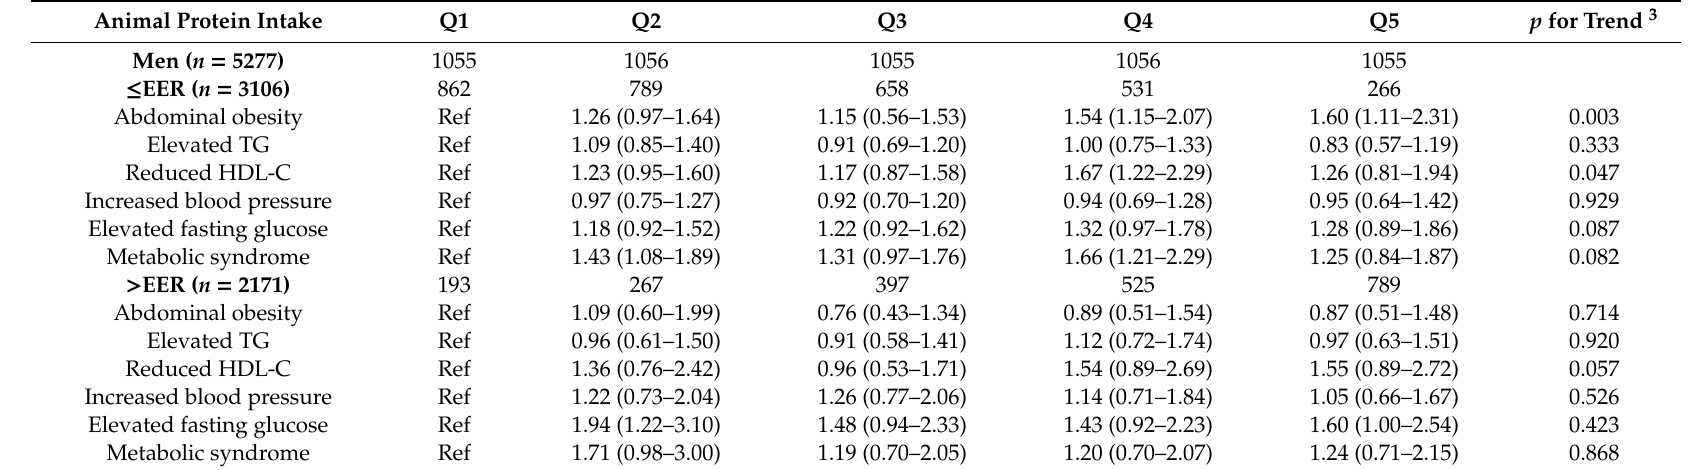
Table 5. Odds ratios and 95% confidence intervals for metabolic syndrome parameters 1 according to quintiles of animal protein intake and the level of